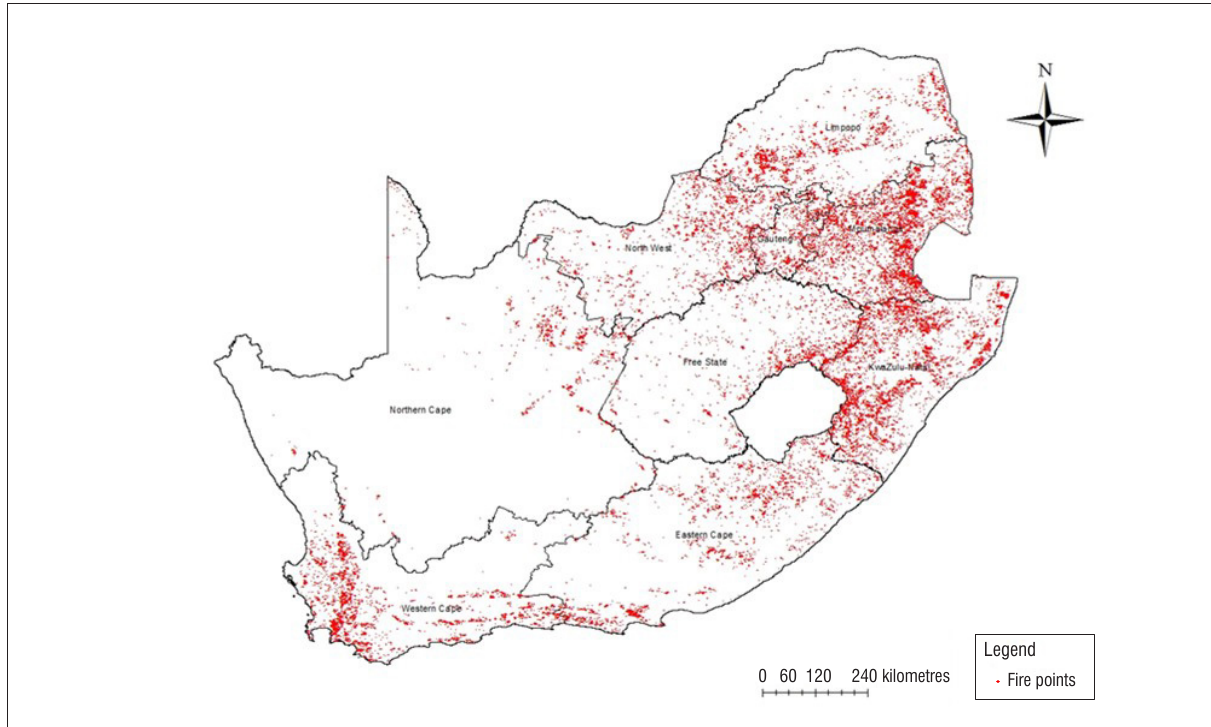
Figure 1: Fire distribution in South Africa between 2003 and